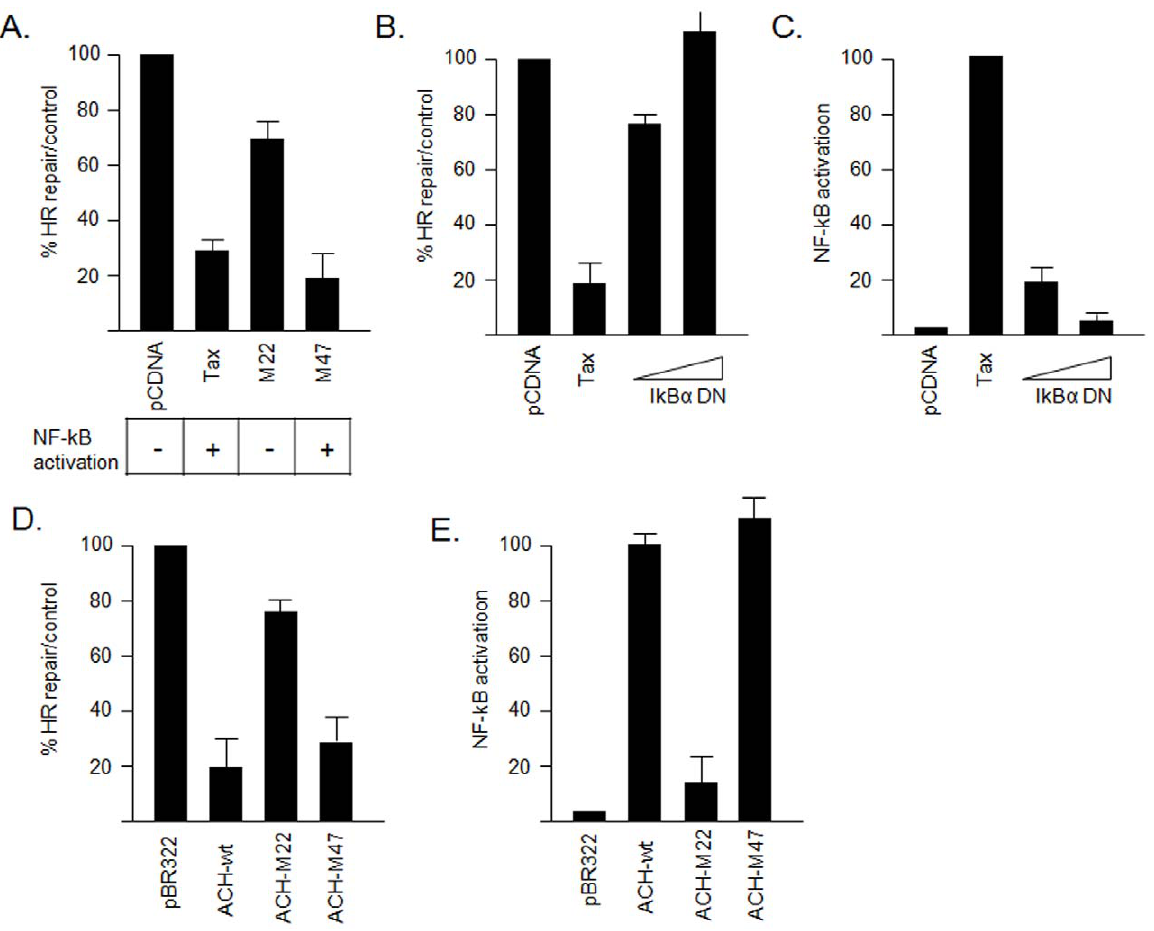
Figure 4. Tax inhibits the DDSB HR DNA repair through activation of NF-kB. A) Representation of in vivo HR assays using the DR-GFP HR reporter and the pI-SceI vectors. B) Jurkat T cells were cotransfected with DR-GFP vector either with the control vector or with the pI-SceI, and along with Tax or Tax mutants M47 or M22 using Amaxa electroporation. Forty-eight hours later the expression of GFP was assessed by FACS analysis. Relative percentage of GFP-expressing cells was represented by histograms corresponding to the average of 3 independent experiments. C) Activation of NF-kB reporter luciferase vector by HTLV-I Tax and Tax mutants M47 and M22. D and E) In vivo HR assay was performed in the presence of Tax and along with coexpression of a phosphorylation-defective dominant negative IkB a mutant that efficiently blocks NF-kB activation by Tax. F) Inhibition of HR by Tax was investigated using HTLV-I molecular clones expressing Tax or Tax mutants M47 and M22 at physiological levels.